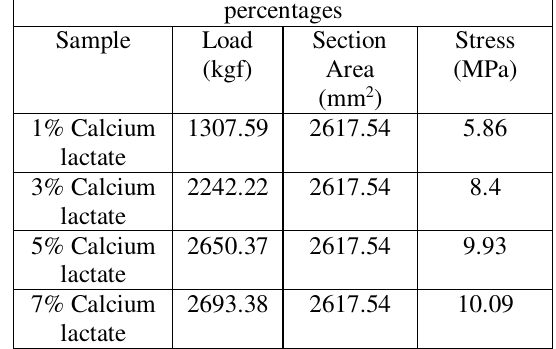
Table 4: Compressive Strength of different percentages